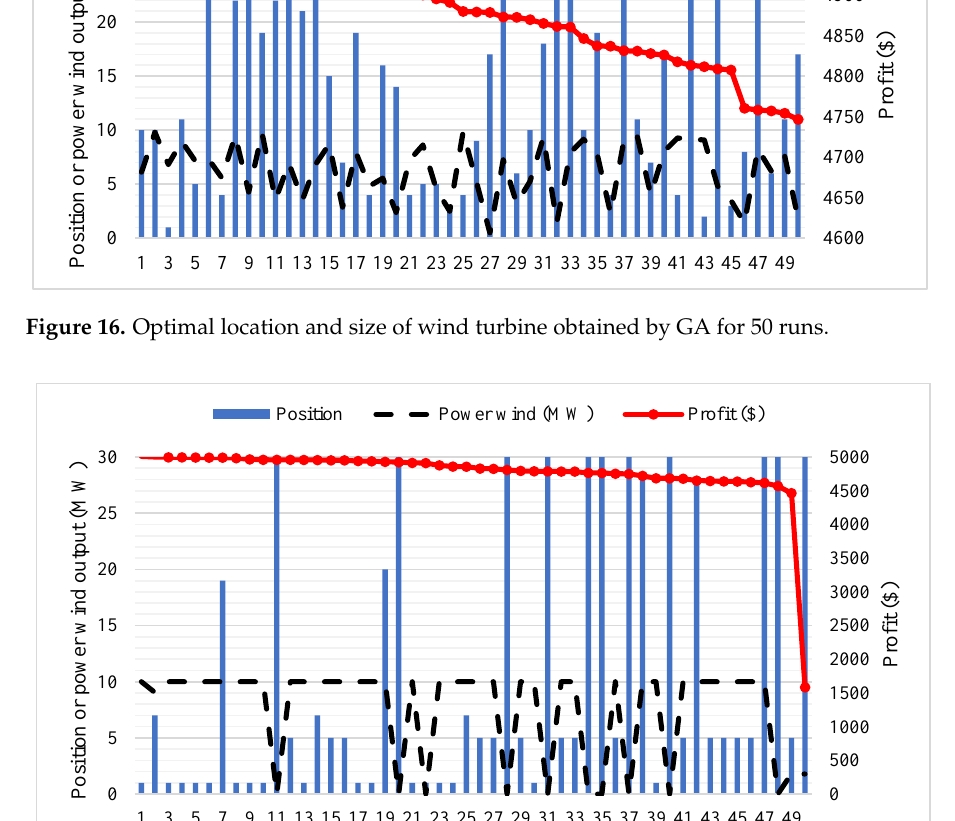
Figure 17. Optimal location and size of wind turbine obtained by PSO for 50 runs.